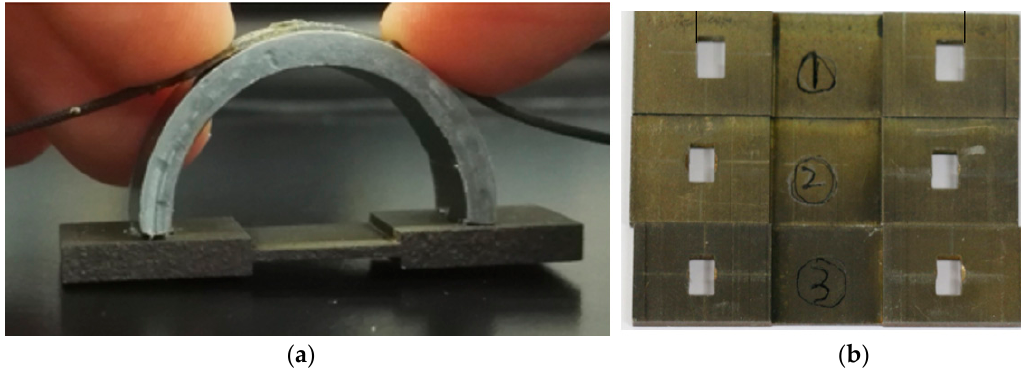
Figure 9. ( a ) Actual corrosion detection sensor. ( b ) The dog-bone-shaped metals.